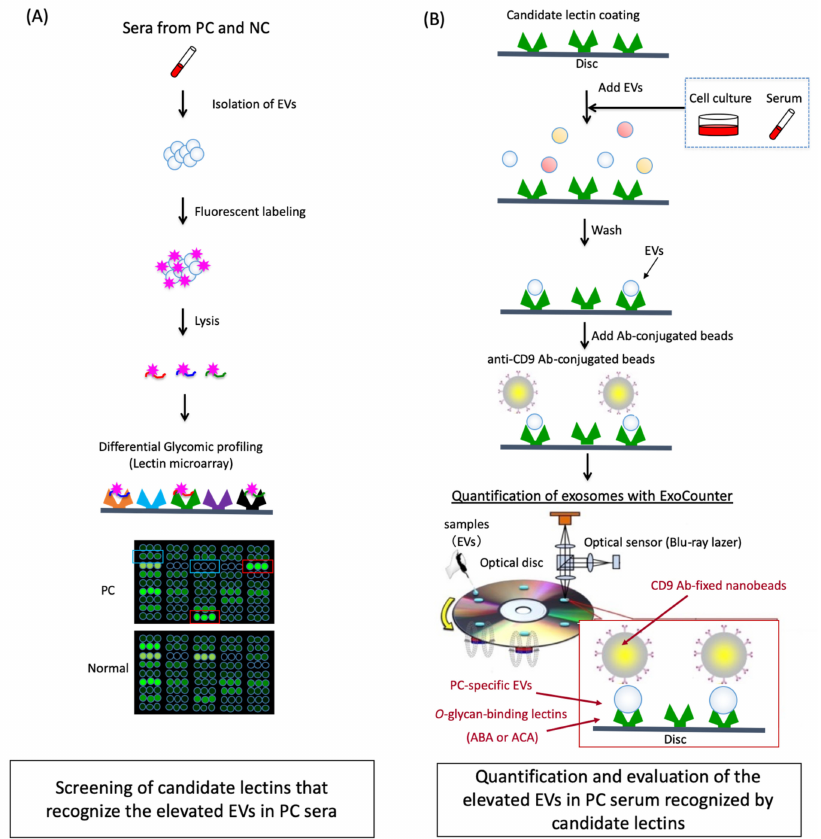
Figure 1. Schematic strategy for screening and quantification of elevated extracellular vesicles (EVs) with specific glycans in pancreatic cancer (PC) sera. ( A ) Screening of candidate lectins that recognize the elevated EVs in PC sera. EVs in PC or normal control (NC) sera were isolated and labeled with fluorescent tags. The glycan profiles of the labeled EVs were then analyzed using lectin microarray, and the candidate lectins that recognize the elevated EVs in PC sera were identified by comparison with NC sera. ( B ) Quantification and evaluation of the elevated EVs in PC serum recognized by candidate lectins. The candidate lectins were coated on the optical disc of the ExoCounter system. The lectin-binding EVs in the PC sera or the cell lines were captured on the disc and labeled with the anti-CD9 Ab-conjugated nanobeads. The absolute numbers of labeled-EVs were quantified using the optical disc drive of the ExoCounter. NC, normal controls; PC, pancreatic cancer; EV, extracellular